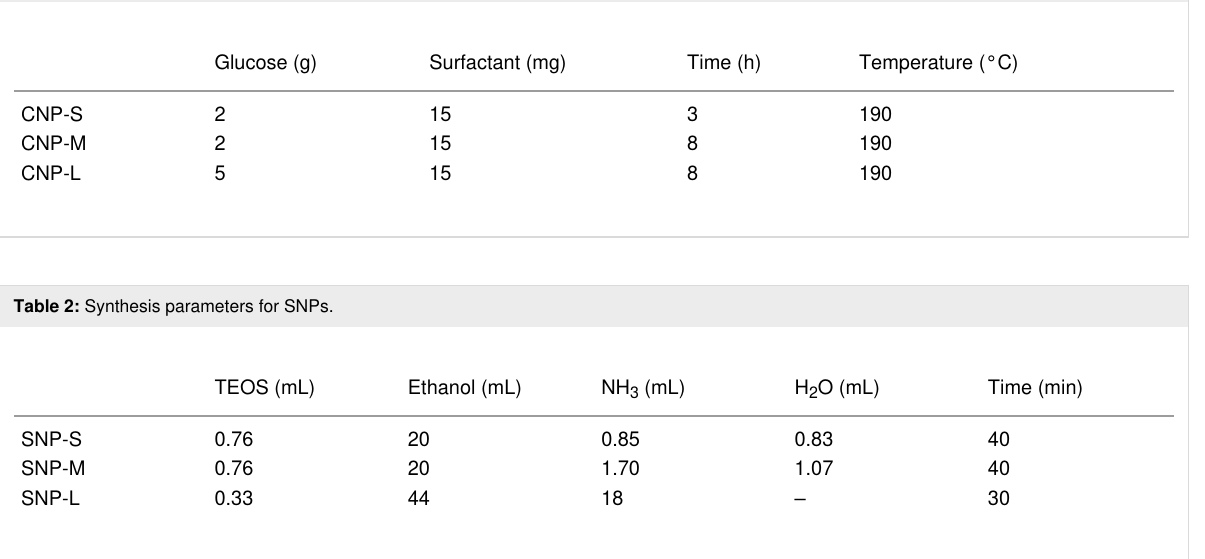
Table 1: Synthesis parameters used for the CNPs.